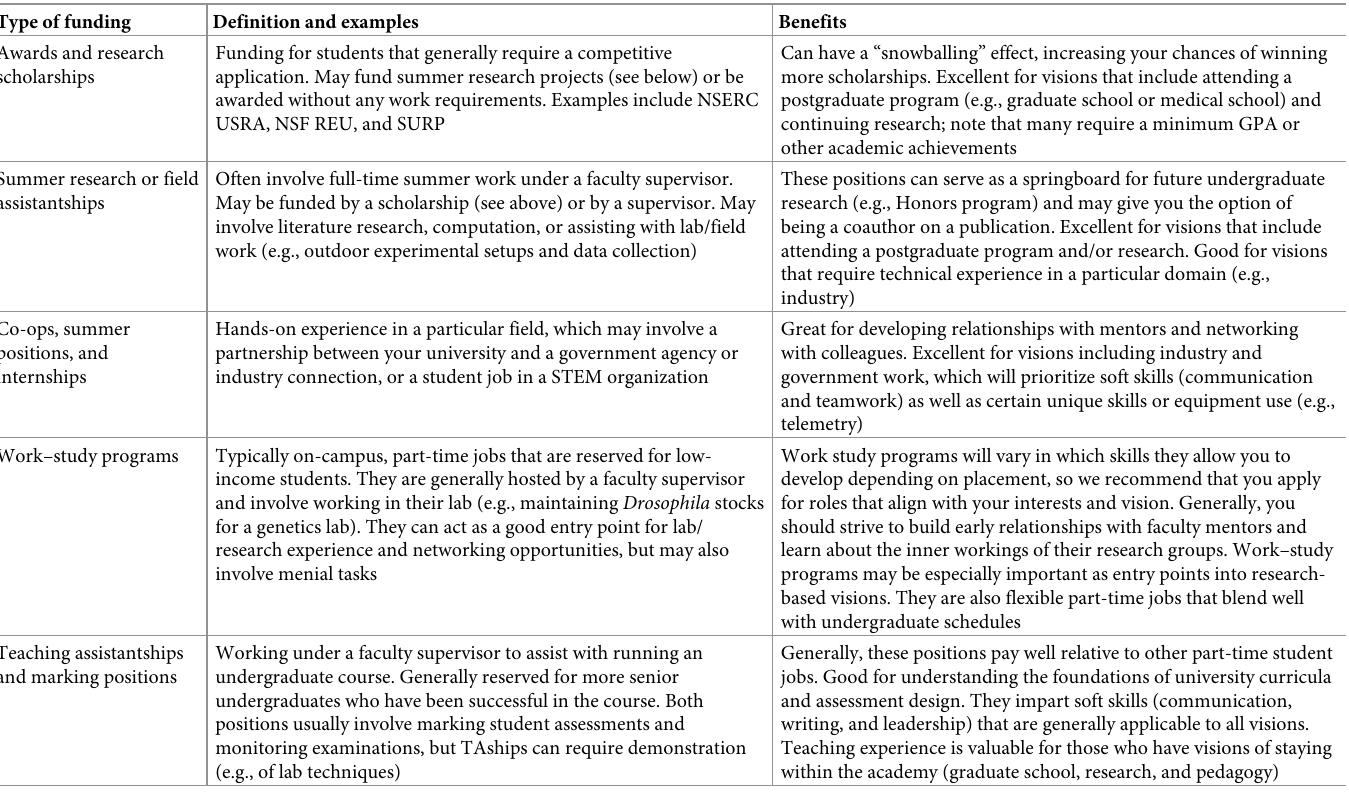
Table 1. Examples of different types of funding that serve the dual purposes of elevating undergraduate students’ careers and providing for their financial